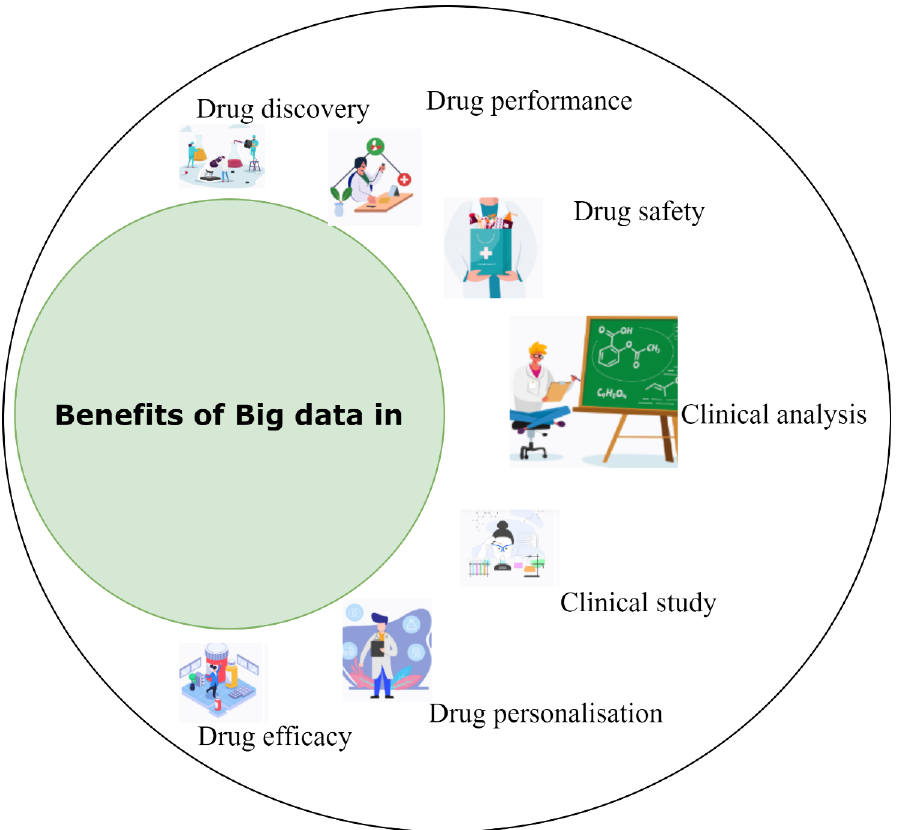
Figure 4. Benefits of BD in Pharmacology, Toxicology and